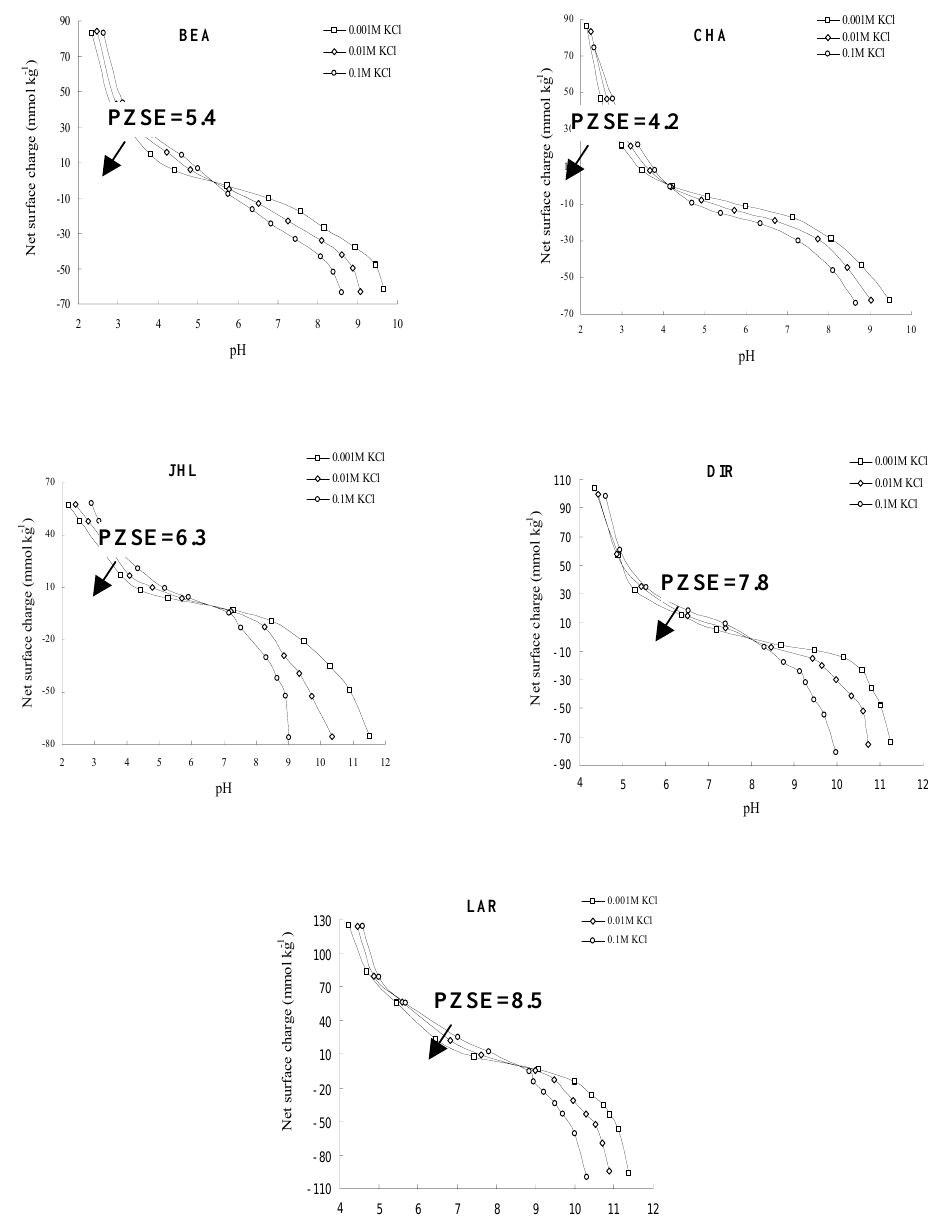
FIGURE 2. Determination of surface charge in experimental soils by potentiometric titration at three different concentrations of KCl.